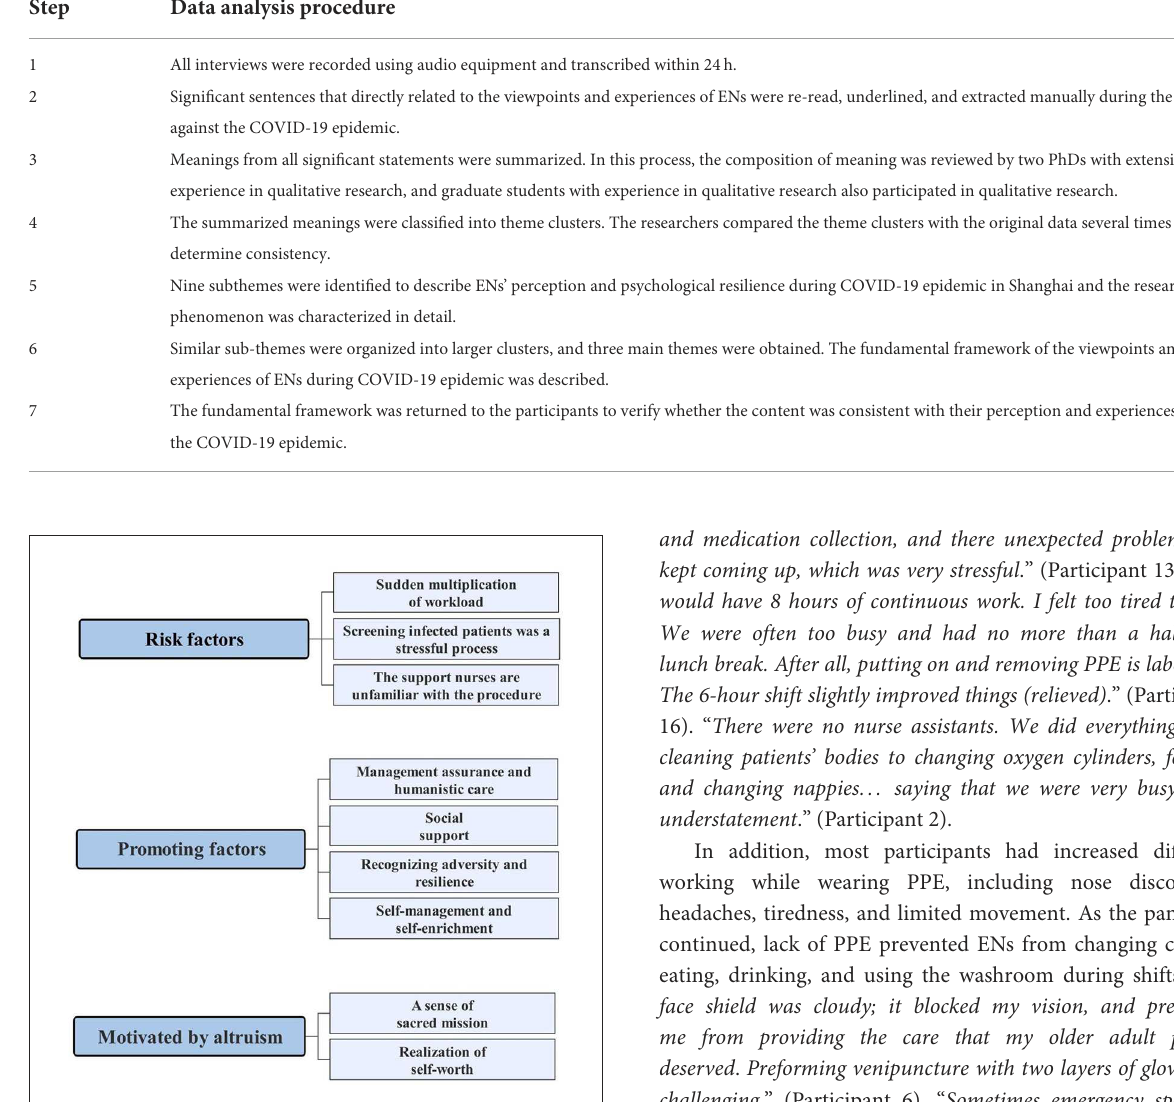
FIGURE1 Themes and